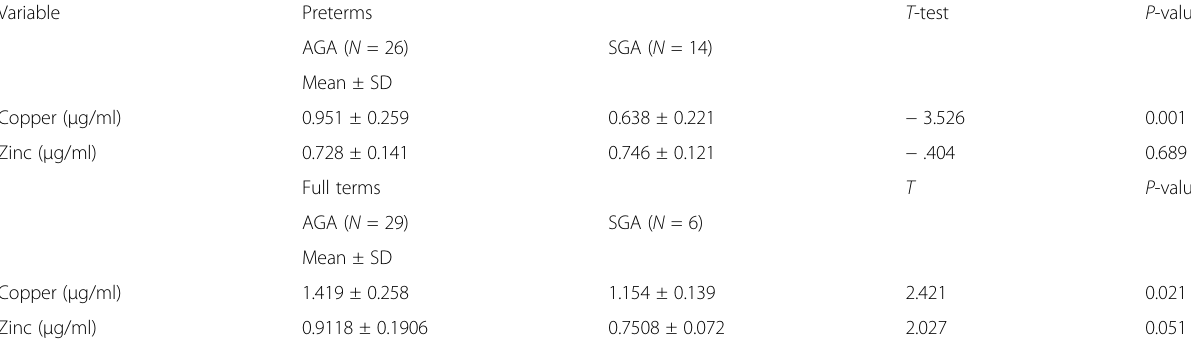
Table 2 Comparison between cord copper and zinc levels in AGA and SGA preterms and full terms Variable